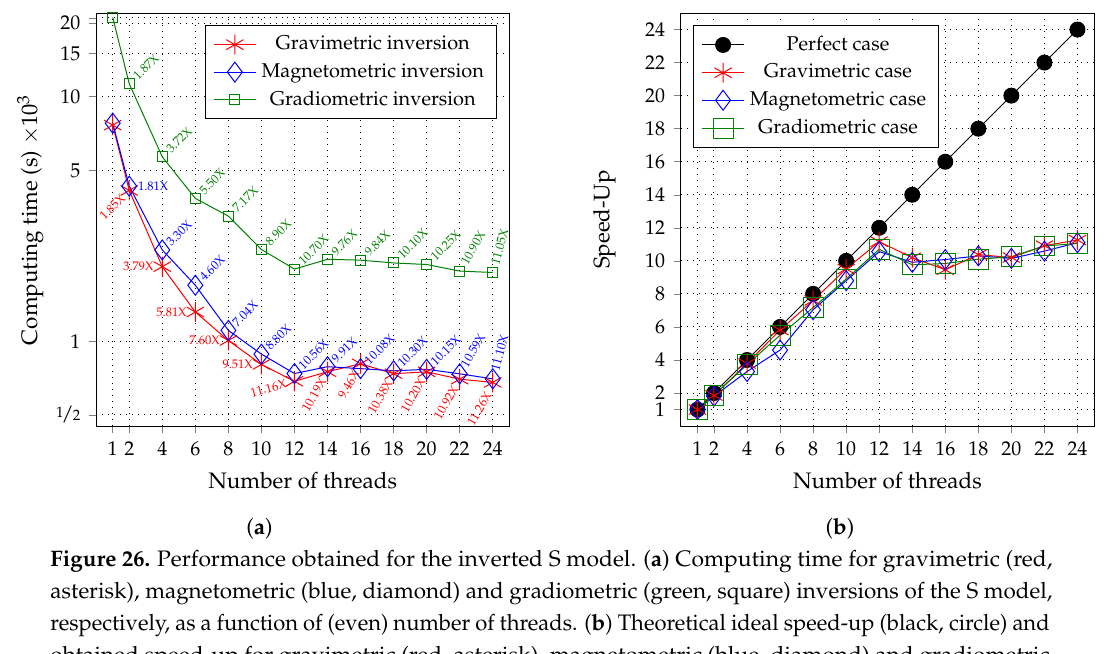
Figure 25. Performance obtained for the inverted the T model. ( a ) Computing time for gravimetric (red, asterisk), magnetometric (blue, diamond) and gradiometric (green, square) inversions of the T model, respectively, as a function of (even) number of threads. ( b ) Theoretical ideal speed-up (black, circle) and obtained speed-up for gravimetric (red, asterisk), magnetometric (blue, diamond) and gradiometric (green, square) inversions of the T model.